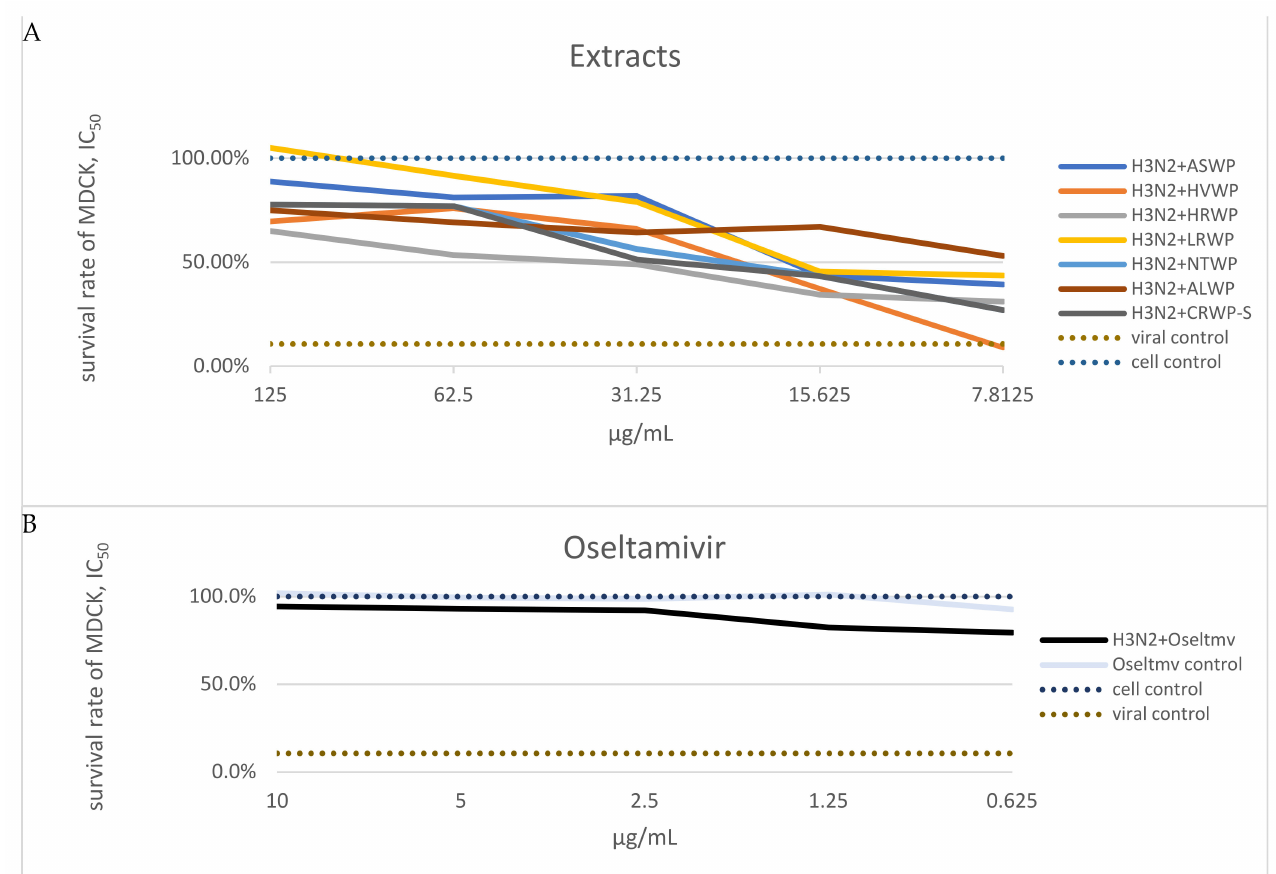
Figure 2. ( A ) Determination of inhibitory concentration values of extracts at which 50% of 100 TCID50 of the A/H3N2 virus was neutralized. Note: Data on extracts NJBAE and PAWP are not shown in the graphs; extract concentrations are expressed in µ g/mL. ( B ) Survival rates of MDCK cells: were left untreated (negative control), treated with oseltamivir, treated with oseltamivir and A/H3N2 virus, or treated with the A/H3N2 virus (positive